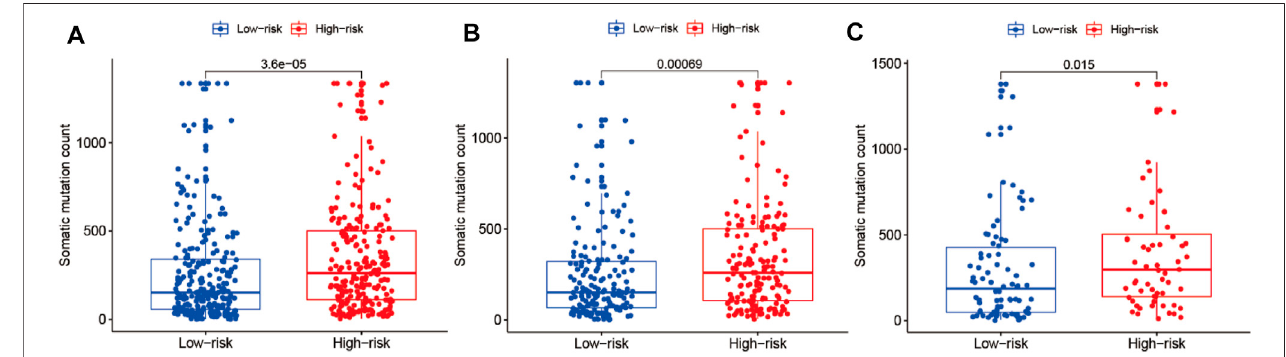
FIGURE 10 | Correlation analysis of the prognostic risk model and somatic mutation counts of LUAD. (A – C) Differential analysis of somatic mutation counts in the prognostic model for the high- and low-risk cohorts.